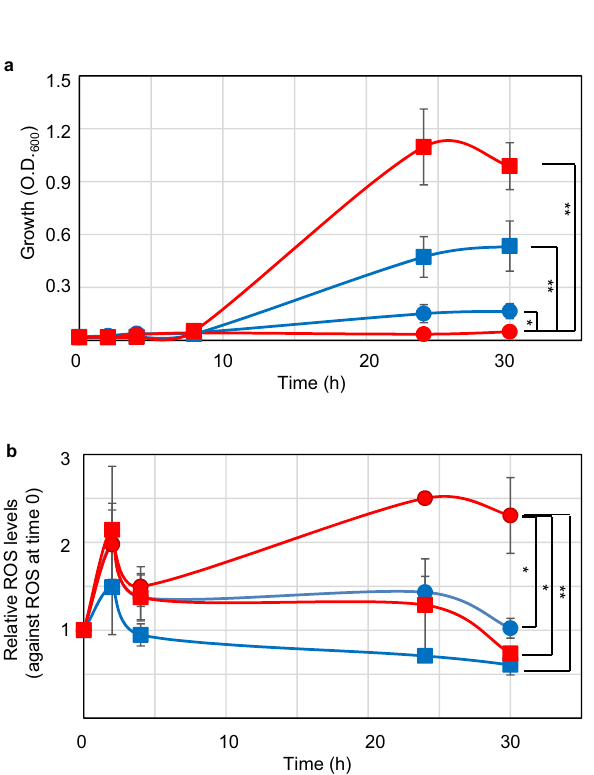
Figure 5. Effect of culture medium on growth and ROS levels in ΔrecA306 polA25 cells. ( a ) Effect of medium on ΔrecA306 polA25 cell growth. Fully grown TK1230 or TK1224 cells were inoculated in either M9GCAA or LB medium at 2 × 10 7 particles/mL (approximately 0.01 OD 600 ). Cell growth was measured using OD 600 at the indicated times. TK1230 cells (round) and TK1224 cells (square) in M9GCAA (blue) or L medium (red) are shown. The results are shown as means ± SEM (n ≥ 4). OD 600 at 30 h were analysed using Welch’s t tests (n = 7). Asterisks and double asterisks indicate p < 0.05 and p < 0.01, respectively. ( b ) Effect of culture medium on ROS levels of ΔrecA306 polA25 cells. Fully grown TK1230 or TK1224 cells were inoculated in either M9GCAA or L medium at 2 × 10 7 particles/mL (approximately 0.01 OD 600 ). Average ROS levels (RFU) were measured at the indicated times. Symbols are the same as those described in ( a ). The results are shown as the mean ± SEM (n ≥ 4). Relative ROS levels at 30 h were analysed using Welch’s t tests (n = 7). Asterisks and double asterisks indicate p < 0.05 and p < 0.01,